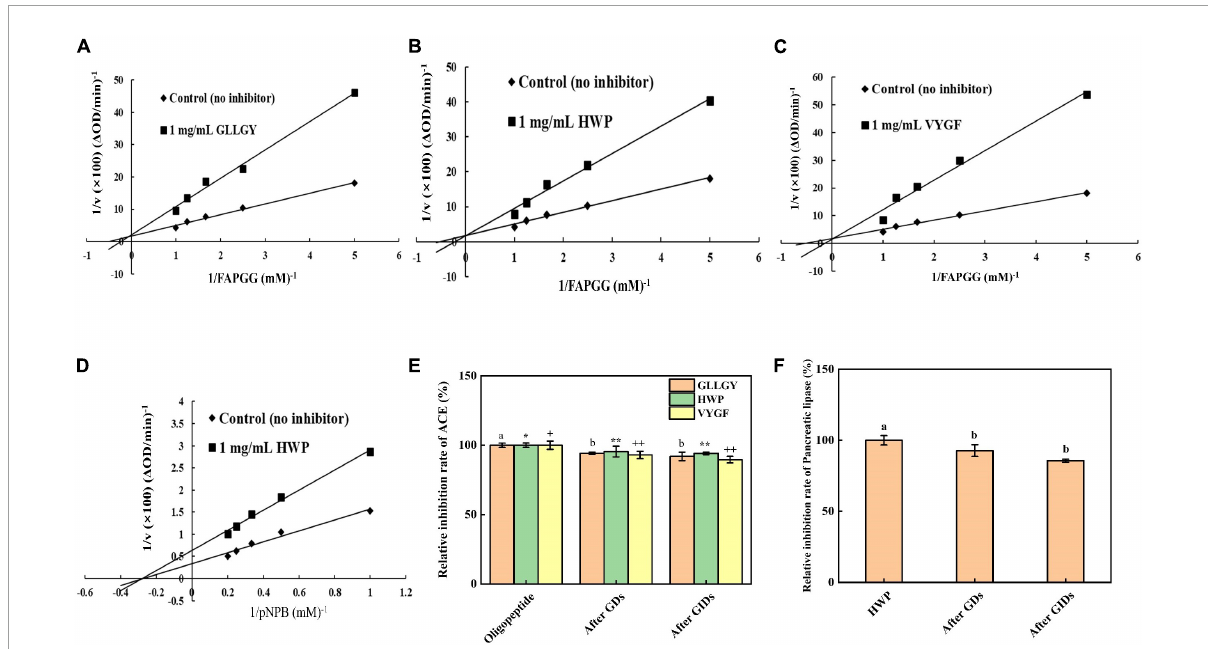
FIGURE3 Lineweaver–Burk plots of ACE-catalyzed reactions in the presence of (A) GLLGY, (B) HWP, and (C) VYGF. Lineweaver–Burk plots of pancreatic lipase-catalyzed reactions in the presence of (D) HWP. Each dot represents a mean of three independent experiments conducted in triplicates. Effect of simulated GI digestion on (E) ACE activity and (F) pancreatic lipase activity. The small letters represent the significant difference p < 0.05.